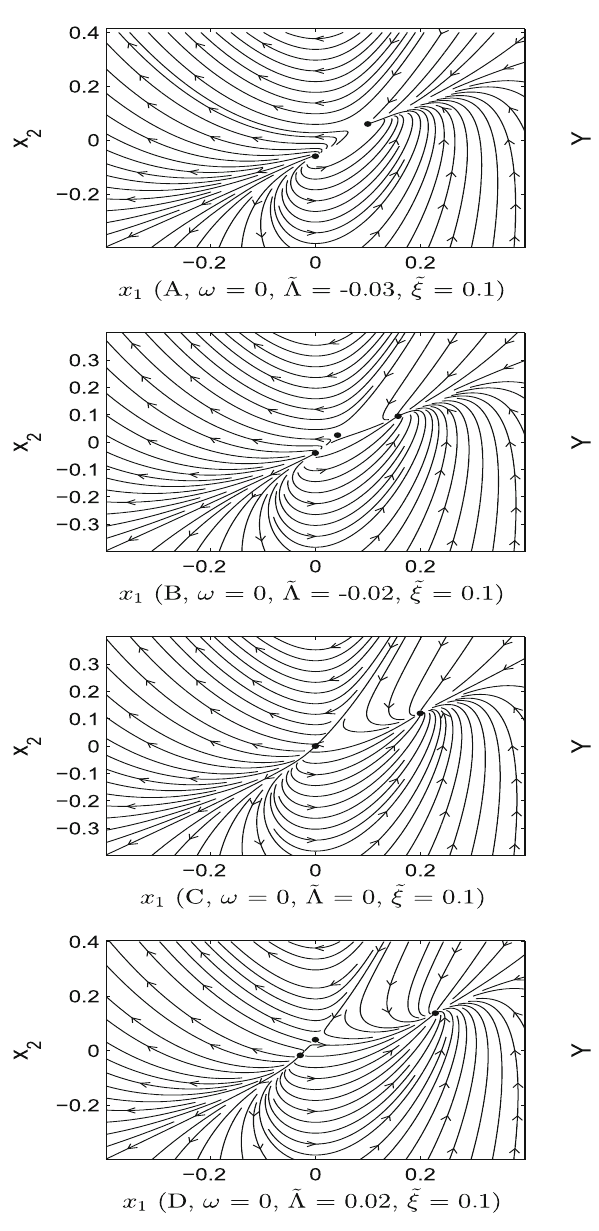
Fig. 17 Uncompact (left panel) and compact (right panel) phase por- traits when viscosity is included, ˜ ξ = 0 . 1 for dust case (ω = 0 ) but with different ˜ (cid:4) . Representative cases are ˜ (cid:4) = {− 0 . 03 , − 0 . 02 , 0 , 0 . 02 } . x 1